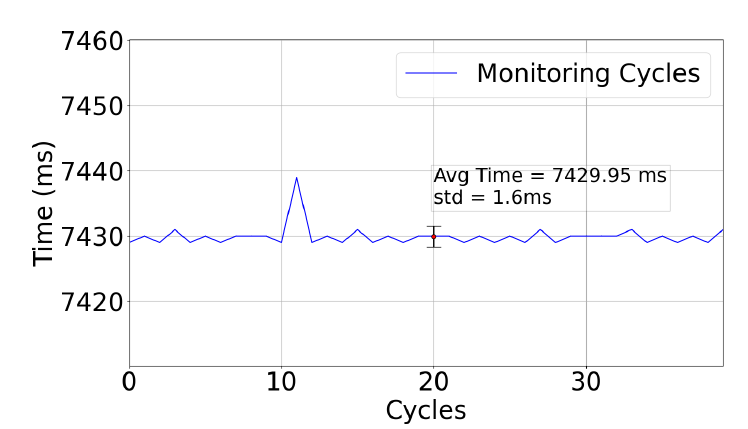
Figure 15. Monitoring Cycle